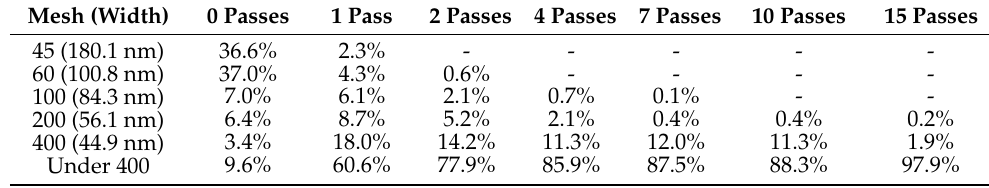
Table 2. Mass fractions resulting from fractionation by the size of the different CNF dispersions. Mesh (Width) 0 Passes 1 Pass